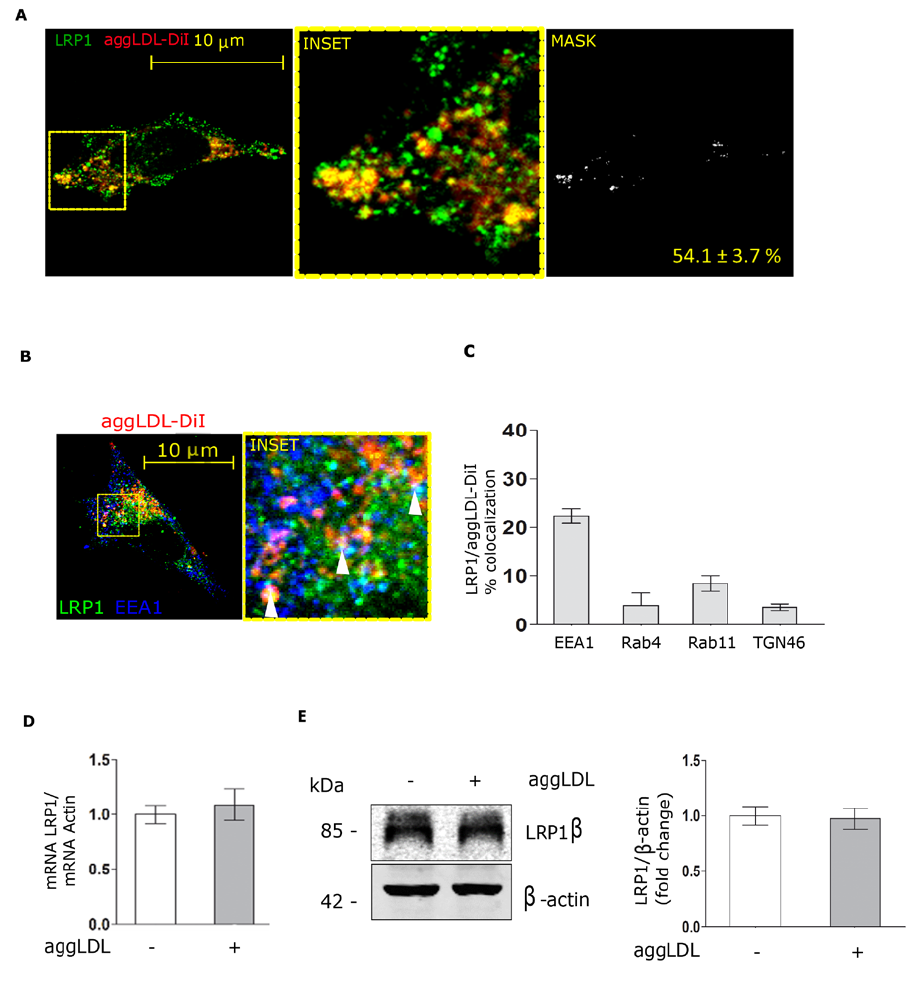
Figure 2. Intracellular distribution and expression level of LRP1 in HL-1 cells. ( A ) Confocal microscopy of HL-1 cells incubated in the absence or presence of 100 µg/mL aggLDL-Dil for 8 h. LRP1 in green and aggLDL-DiI in red are shown. Inset: 4× magnification of framed region in the dotted lines. The MASK represents the binary image where co-localization pixels between LRP1 and aggLDL are shown in white. The corresponding quantitative analysis is shown as the mean ± SD of the percentages of co-localization. The images are representative of 30 cells per condition, coming from three independent experiments. The scale bar corresponds to 10 µm. ( B ) Confocal microscopy in HL-1 cells incubated with 100 µg/mL aggLDL-DiI for 8 h showing the triple co-localization analysis between LRP1 and aggLDL-Dil together with early endosome marker [EEA1 + ]. The inset represents the 4× magnification of the framed regions in the dotted lines. The white arrowheads indicate vesicles containing triple co-localization sectors. The images are representative of 30 cells per condition, coming from three independent experiments. The scale bar corresponds to 10 µm. ( C ) The bar graph represents the mean ± SEM of the co-localization percentages of the triple co-localization between LRP1, aggLDL-Dil and different intracellular compartment markers (EEA1, Rab4, Rab11, and TGN46), obtained from the quantification performed in 30 cells per condition. ( D ) Quantitative RT- PCR assay to evaluate LRP1 mRNA expression in HL-1 cells exposed to 100 µg/mL aggLDL for 8 h.